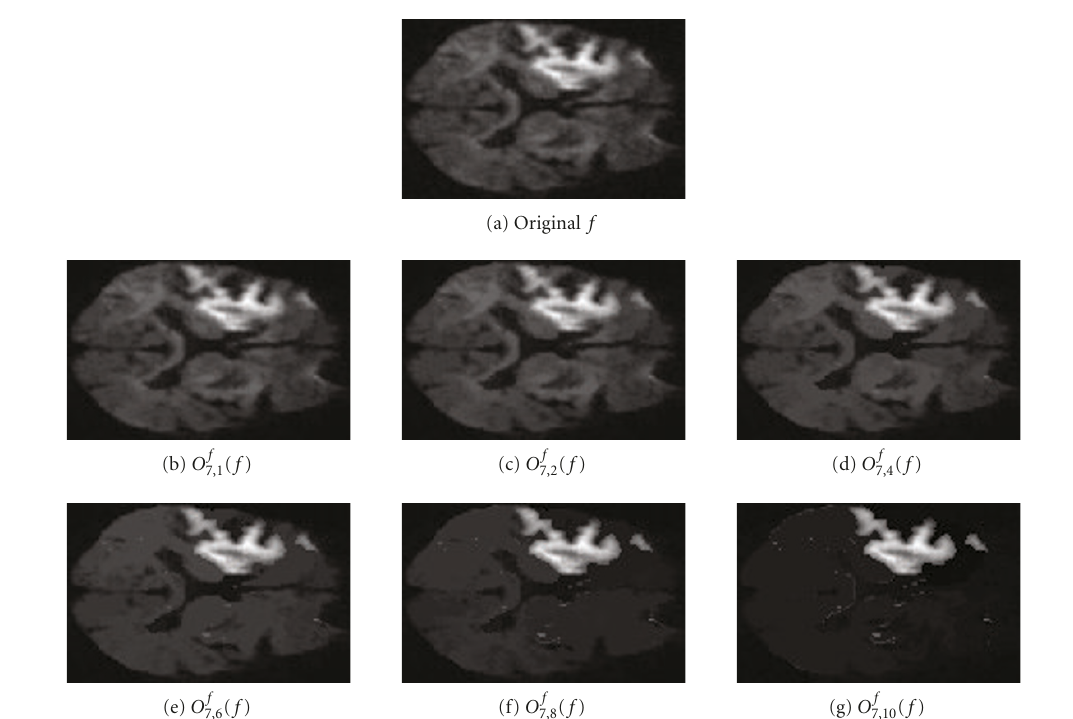
Figure 6: Detection of cerebrovascular accidents. A decomposition process (b)–(g) is achieved with the LAN-based morphological sequential openings applied on the original image (a). The detection of the stroke area seems to be reachable at level p =